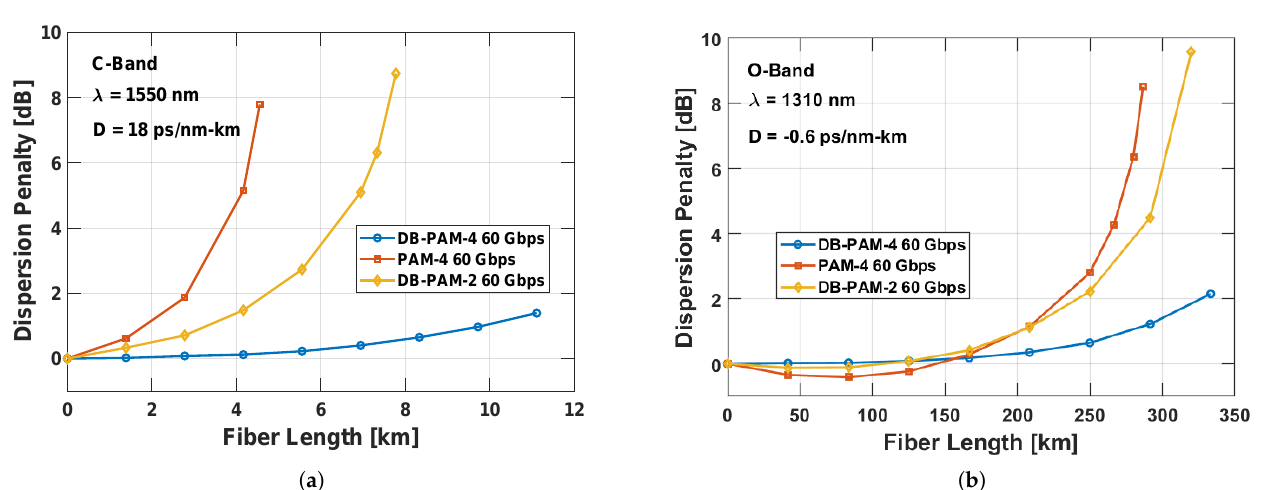
Figure 9. Simulated dispersion penalty as a function of fiber length for different modulation formats employing the high BW system. Transmission in ( a ) C-band and ( b ) O-band is